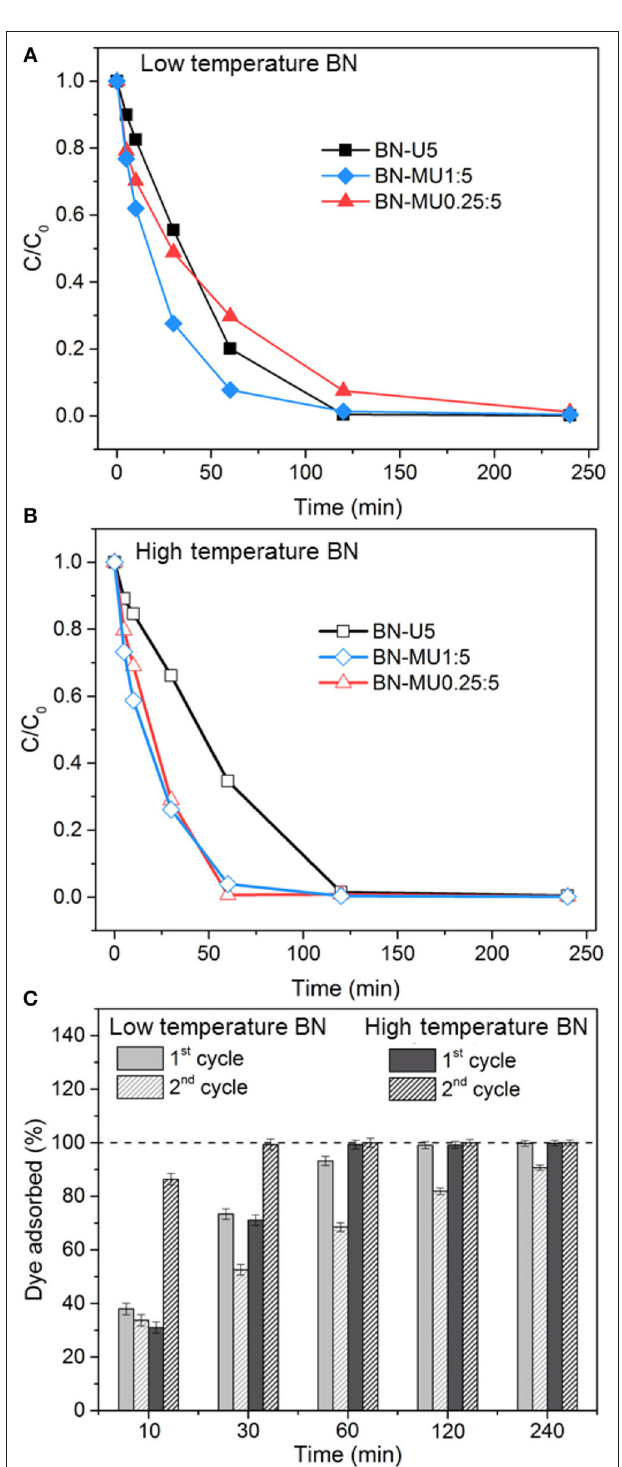
FIGURE 2 | Removal of an organic (Rhodamine B) from water using porous BN samples: (A) RhB sorption over time for the low temperature porous BN samples, (B) RhB sorption over time for the high temperature porous BN samples, (C) evaluation of the recyclability of the best performing porous BN samples at low (BN-MU1:5) and high (BN-MU0.25:5) temperature after regeneration in air at 600 ◦